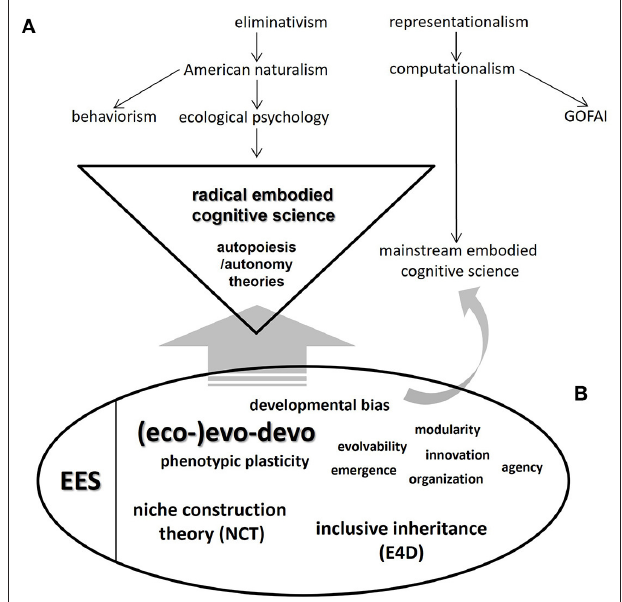
FIGURE 1 | Scheme of the general relationship between (A) the two frameworks derived from the currently existing divide in embodied cognitive science: “mainstream” and “radical embodied cognitive science” ( sensu Ziemke, 2016: p. 6); and (B) the central concepts of evolutionary developmental biology (“Evo-Devo” sensu Müller, 2007b; see also Müller, 2021 ) and the “main branches” of the Extended Evolutionary Synthesis (EES, after Laland et al., 2015). In the latter conceptual aggregation, we include (i) niche construction theory (NCT); (ii) (eco-)evo-devo, where we fuse (the study of) phenotypic plasticity-related phenomena as well as developmental bias, and a number of concepts and theoretical themes and implications of evo-devo sensu stricto ; and (iii) inclusive inheritance. Müller (2007b) additionally defines Evo-Devo in terms of four complementary “research programs”, all of which structure our understanding of the field. “Radical embodied cognitive science” is highlighted (triangle) to stress the stronger compatibility with and/or susceptibility of influence from (broad, straight gray arrow) the (eco-)evo-devo/EES framework. A slender, curved gray arrow pointing to “mainstream embodied cognitive science” indicates a remaining, restricted potential for certain (eco-)evo-devo concepts to help in certain tasks in this relatively conservative branch of cognitive science. To emphasize the usefulness that this renewed evolutionary framework could have for the analysis and construction of artificial emotional systems (AESs) in the context of “embodied AI” research, some basic definitions are provided (see also Table 1 ): (a) Developmental bias is the “source of bias in phenotypic variation (...) which does not only constrain but also facilitate and direct evolution” (Laland et al., 2015, p. 5); (b) developmental (or phenotypic ) plasticity is “the capacity of an organism to change its phenotype in response to the environment” (Müller, 2007b; Laland et al., 2015, treats this concept as the basis for his conception of “eco-evo-devo”); (c) modularity is a feature of organismal parts/structures “pervasive at all levels (...), from the genetic to the developmental, anatomical and behavioral” that distinguishes them in terms of “greater internal than external integration” as well as “repetitiveness (...) persistence and reuse” (Müller, 2007b, p. 944); (d) evolvability is “ the intrinsic potential of a given lineage to produce heritable phenotypic variation”, related to “variational capacities of genomes (as) functions of the developmental systems in which they are embedded” (Müller, 2007b, p. 946); (e) emergence “refers to phenomena outside the scope of variation, in particular to the modes of origination, innovation and novelty in phenotypic evolution” (Müller, 2007b, p. 946); (f) innovation refers to “instances of novelty”, due to “the redeployment of existing regulatory circuits” or “the mechanisms of epigenetic causation” (Müller, 2007b, p. 945); (g) (phenotypic) organization emphasizes that “the causal basis for phenotypic form resides not in population dynamics or (...)